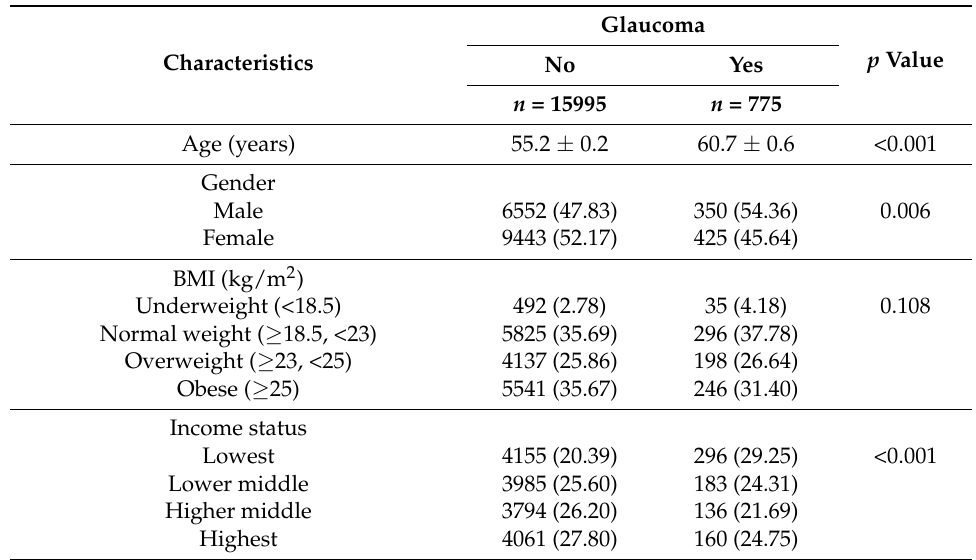
Table 1. Baseline